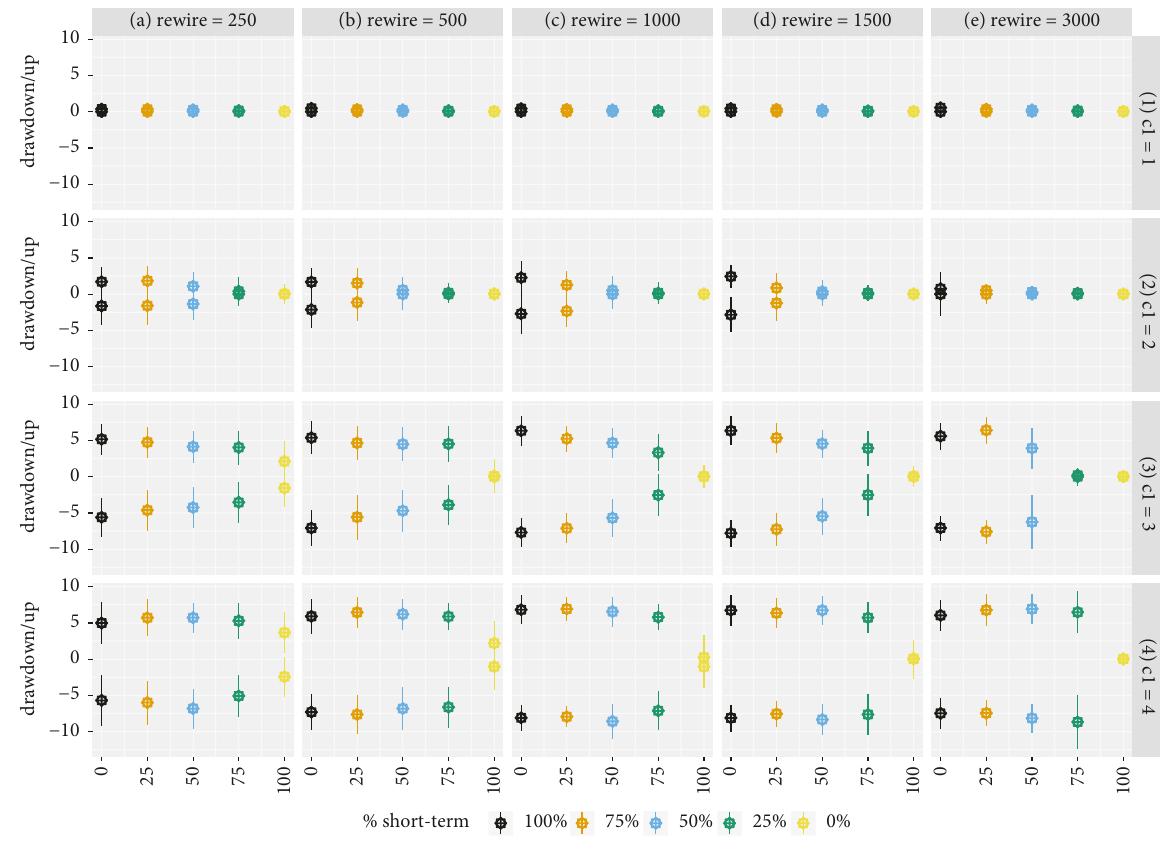
Figure 5: The maximum drawdowns and drawups recorded in the market across the various settings with rewiring. The boxes represent the median, while the lines represent the upper and lower maximums recorded for each